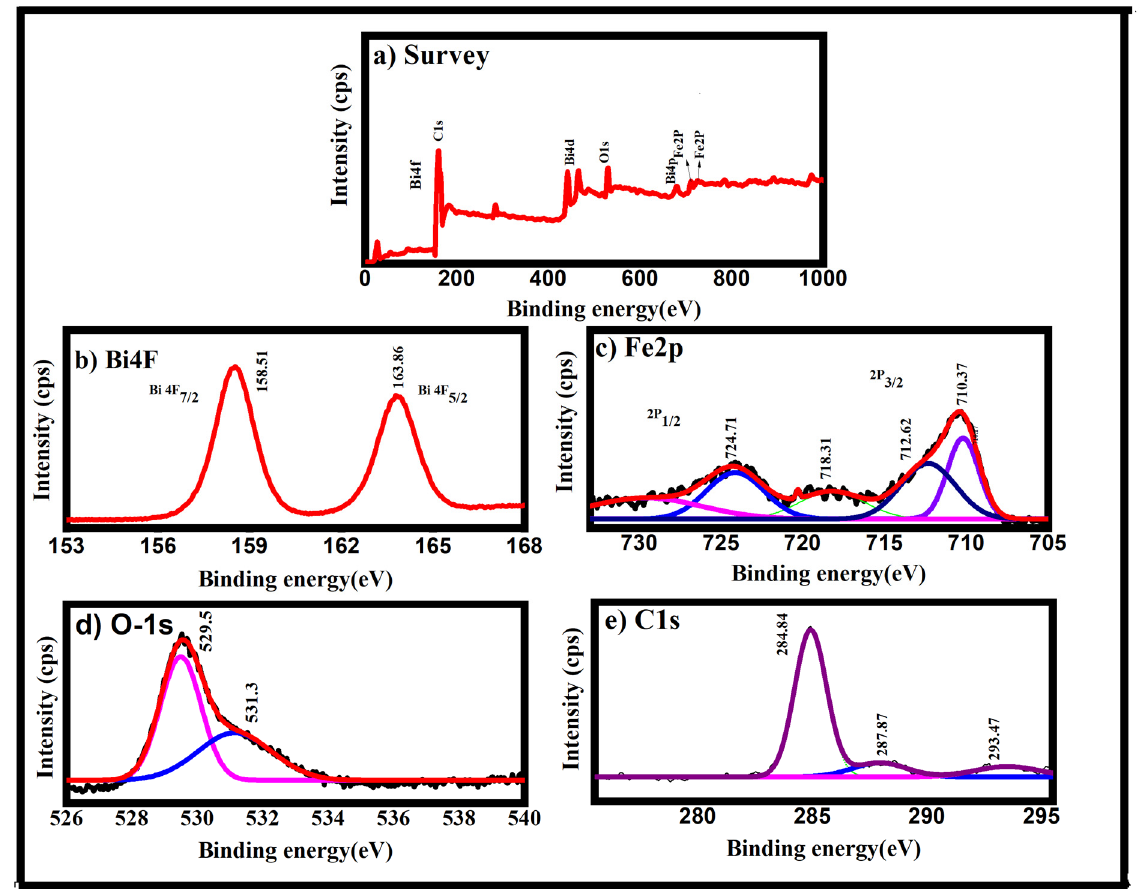
Figure 6. XPS survey ( a ), Bi-4f ( b ), Fe-2p ( c ), O-1s( d ) and C-1s ( e ) spectrum of BFO (2% excess bismuth BFO) sample.